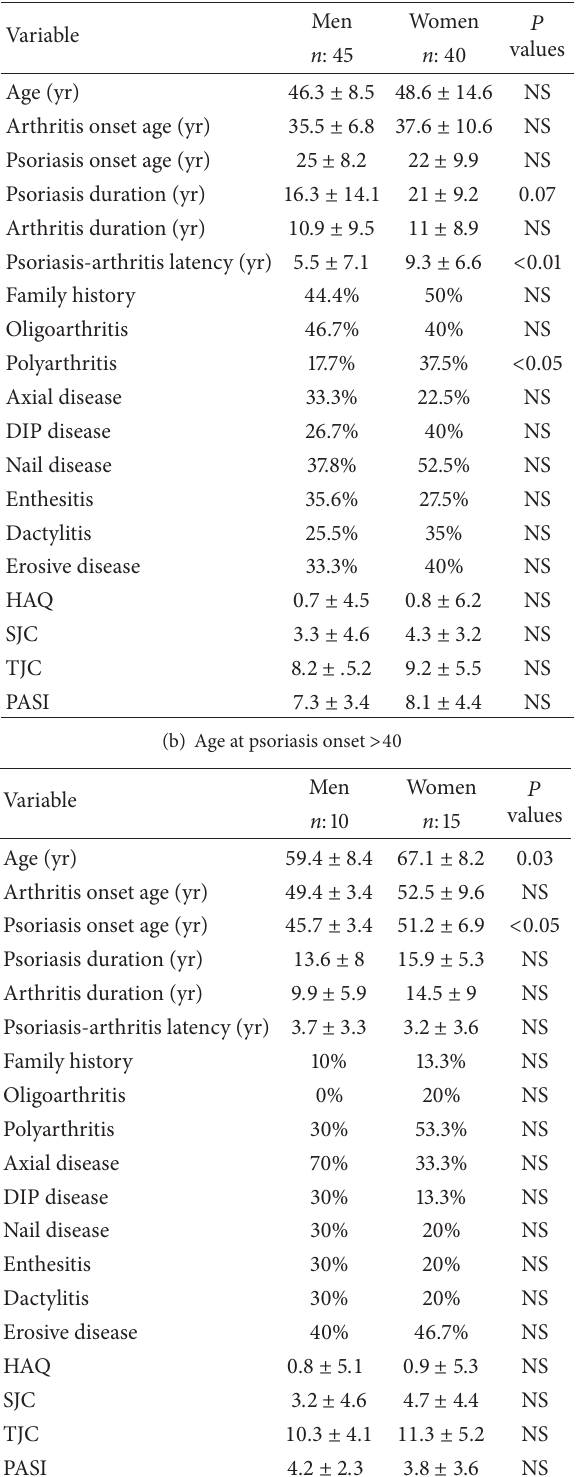
Table 2: Differences between men and women according to age at psoriasis onset (cutoff: 40years).